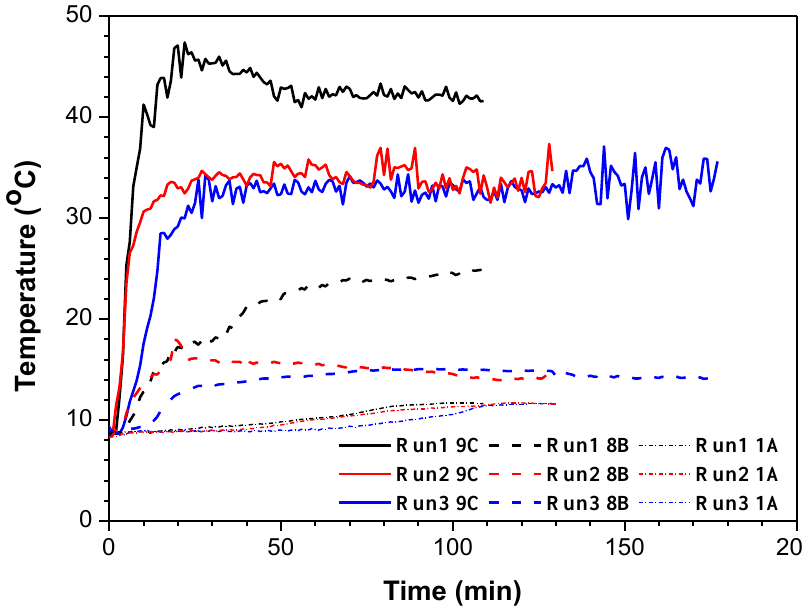
Figure 6. Changes in the temperatures at 9C, 8B, and 1A during hydrate dissociation in sediments with different practical sizes.